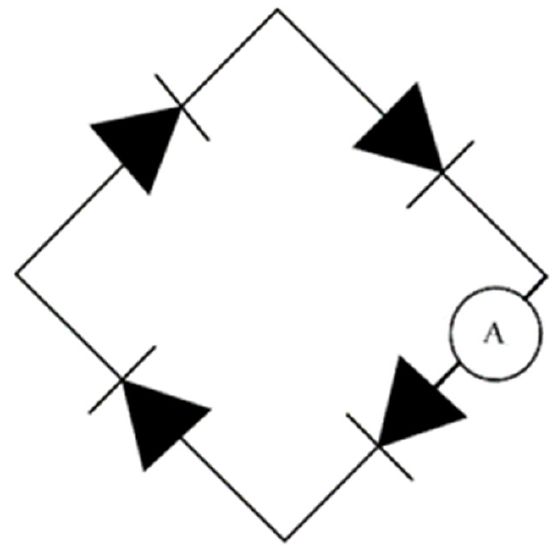
Figure 4. Thermal noise in a looped conductor with resistance R k. .